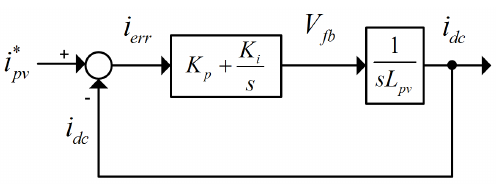
Figure 4. Simplified PI current